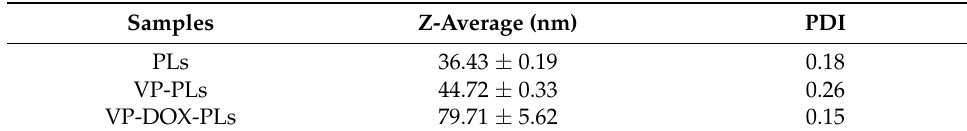
Table 2. DLS data of PLs, VP-PLs, and DOX-VP-PLs.